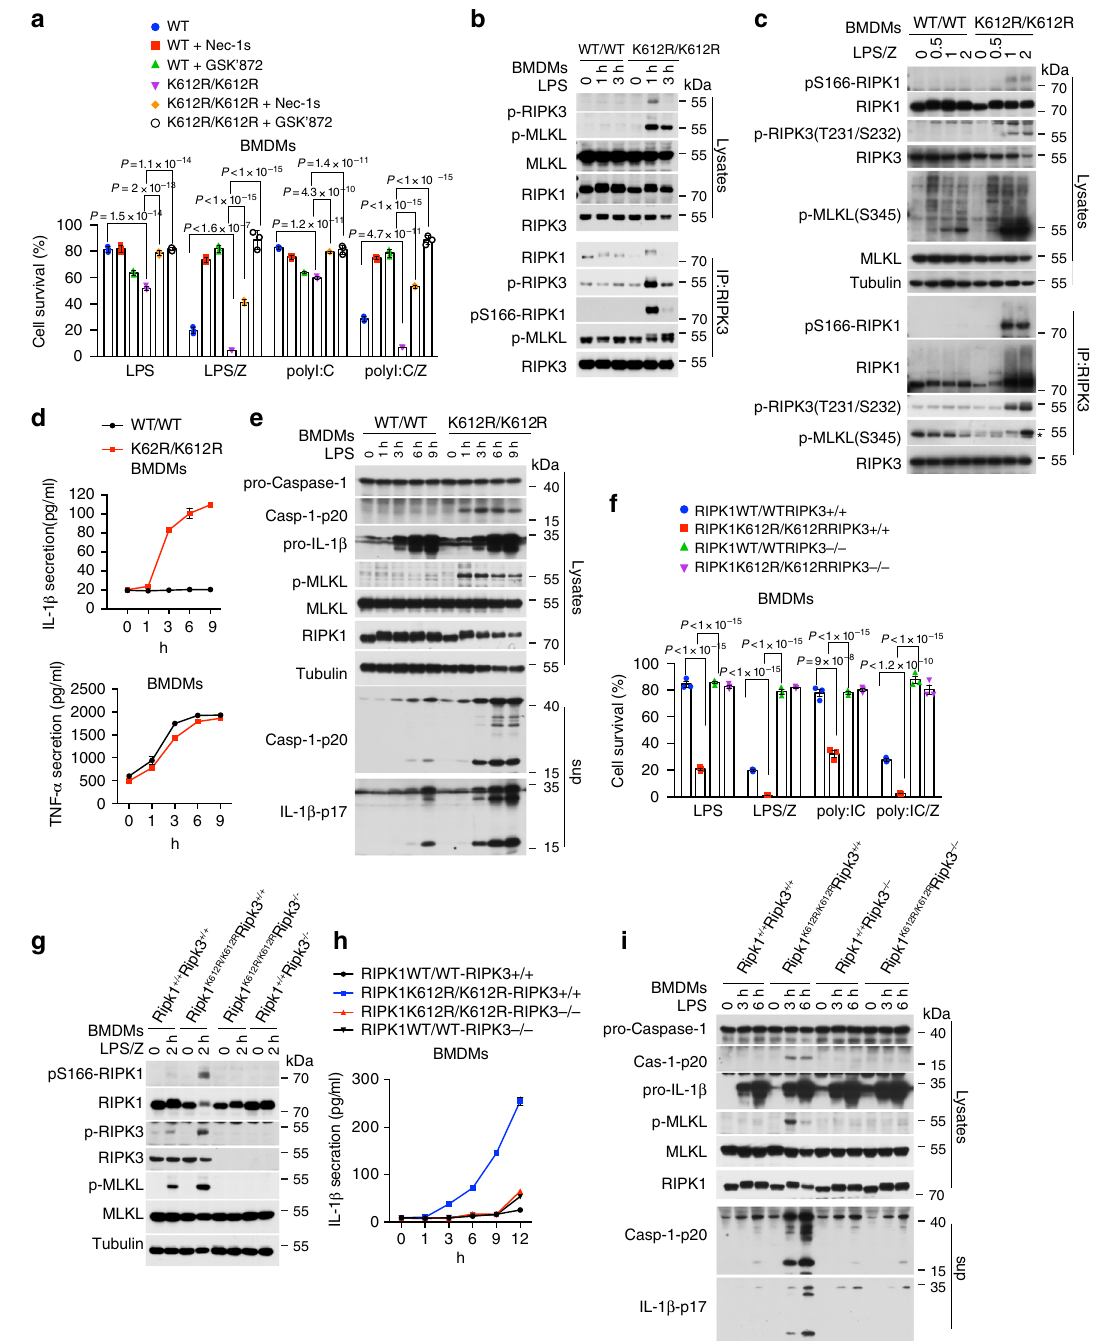
Fig. 6 RIPK1 K612R mutation promotes necroptosis and caspase-1 activation mediated by TLR3/4. a Primary Ripk1 + / + and Ripk1 K612R/K612R BMDMs were pretreated with Nec-1s (10 μ M), GSK ’ 872 (10 μ M) or vehicle in the presence or absence of Z-VAD (25 μ M) for 30 min respectively, and then treated with Poly (I:C) (20 μ g/ml) or LPS (50 ng/ml) as indicated for 10 h. Cell survival was measured by CellTiterGlo. Data are presented as mean ± SEM of n = 3 biologically independent samples. Two-way ANOVA with Bonferroni ’ s multiple comparison test. b , c Complex IIb was isolated by RIPK3 antibody and analyzed by western blotting in primary BMDMs isolated from indicated mouse strains pretreated with Z-VAD (25 μ M) or vehicle for 30 min, and then treated with LPS (50 ng/ml) for indicated time points. Uncropped blots in the Source Data fi le. d Quanti fi cation of IL-1 β and TNF α in the cultural supernatant from primary Ripk1 + / + and Ripk1 K612R/K612R BMDMs treated with LPS (50 ng/ml) for indicated time points by ELISA. e Western blotting analysis of the cell lysates and cultural supernatant of Ripk1 + / + and Ripk1 K612R/K612R primary BMDMs treated with LPS (100 ng/ml) for indicated time points. Uncropped blots in the Source Data fi le. f Primary BMDMs isolated from indicated mouse strains were treated with LPS (50 ng/ml) plus Z-VAD (25 μ M) or Poly (I:C) (20 μ g/ml) or plus Z-VAD (25 μ M) as indicated for 10 h. Cell survival was measured by Cell TiterGlo. Data are presented as Mean±SEM of n = 3 biologically independent samples. Two-way ANOVA with Bonferroni ’ s multiple comparison test. g Western blotting analysis